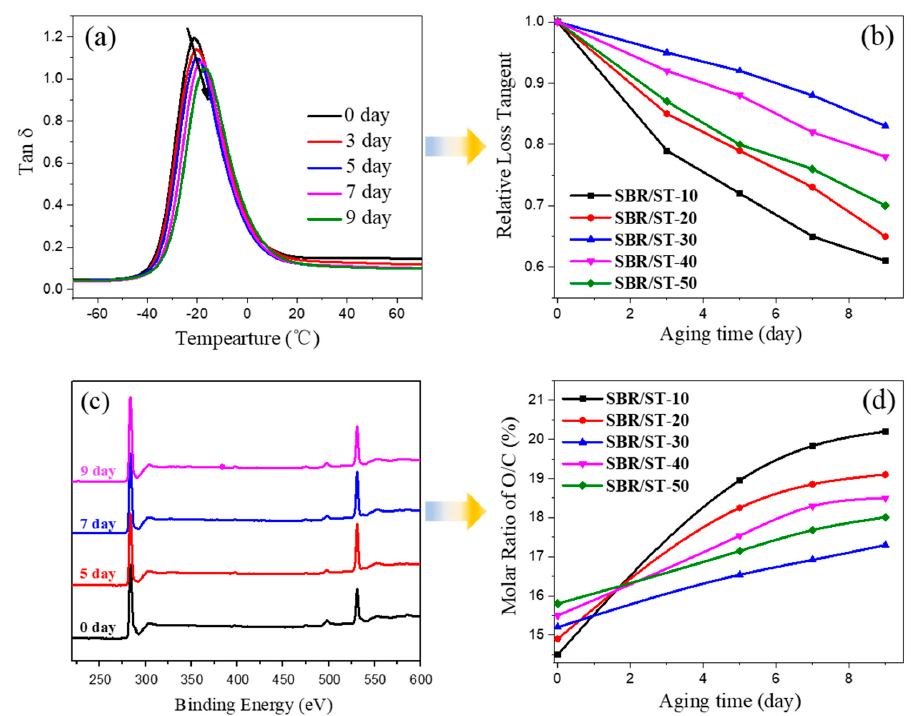
Figure 5. ( a ) DMA curves of tan δ vs. temperature of SBR/ST-30 with different thermo-oxidative aging time, ( b ) Relative tan δ peak value for SBR / silica-s-TP composites vs. aging time, ( c ) XPS spectrum time, ( b ) Relative tan δ peak value for SBR/silica-s-TP composites vs. aging time, ( c ) XPS spectrum of of SBR / ST-30 during aging at 100 ◦ C for various times, and ( d ) molar ratio of O / C of SBR / silica-s-TP SBR/ST-30 during aging at 100 °C for various times, and ( d ) molar ratio of O/C of SBR/silica-s-TP composites vs. aging composites vs. aging time.